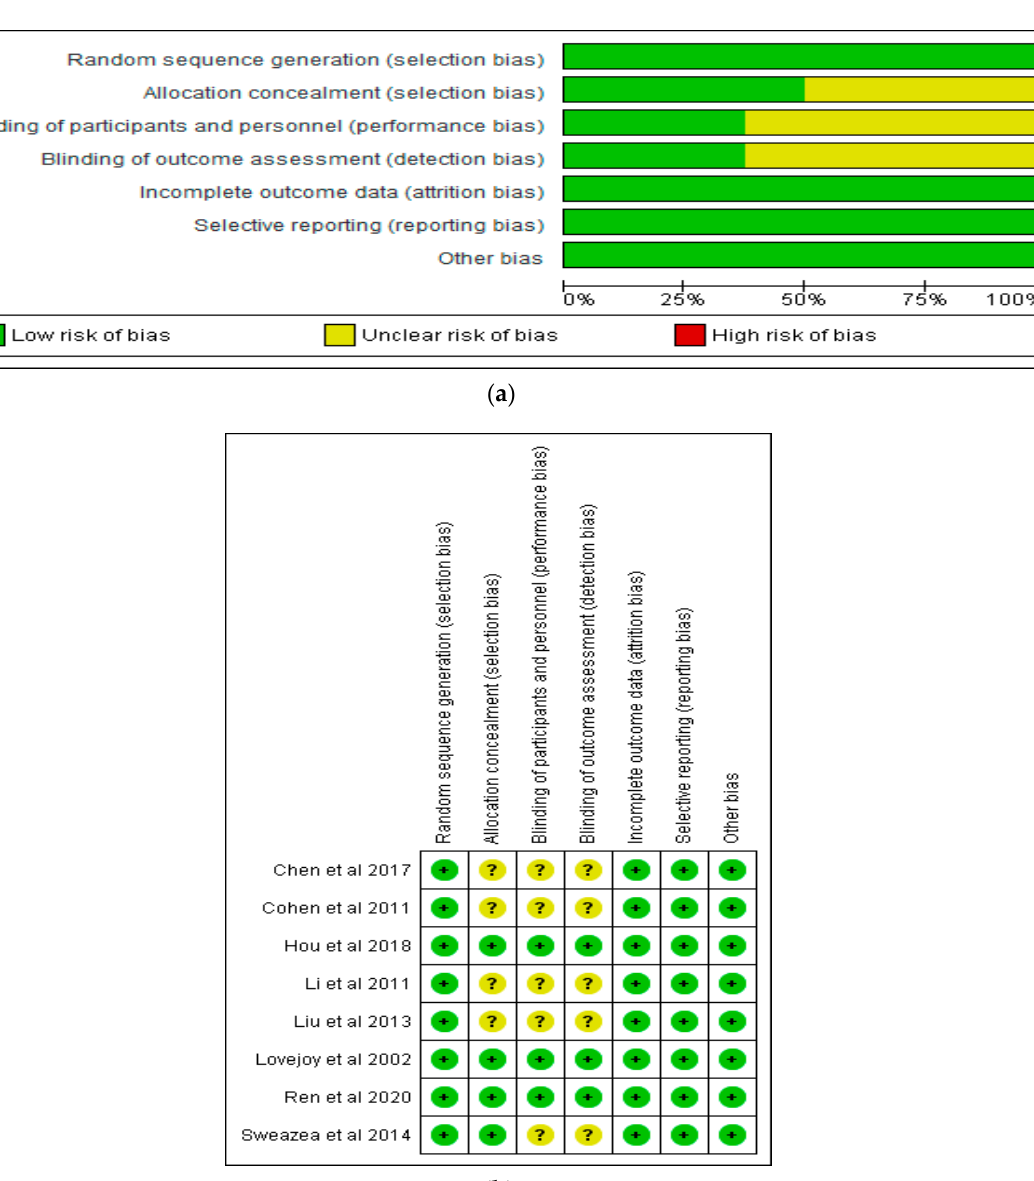
Figure 2. Shows ( a ) risk of bias graph and ( b ) risk of bias summary of studies